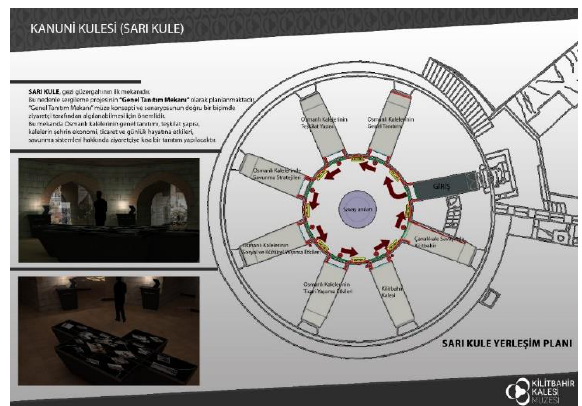
Photo 11 : Yellow Tower Plan, K.